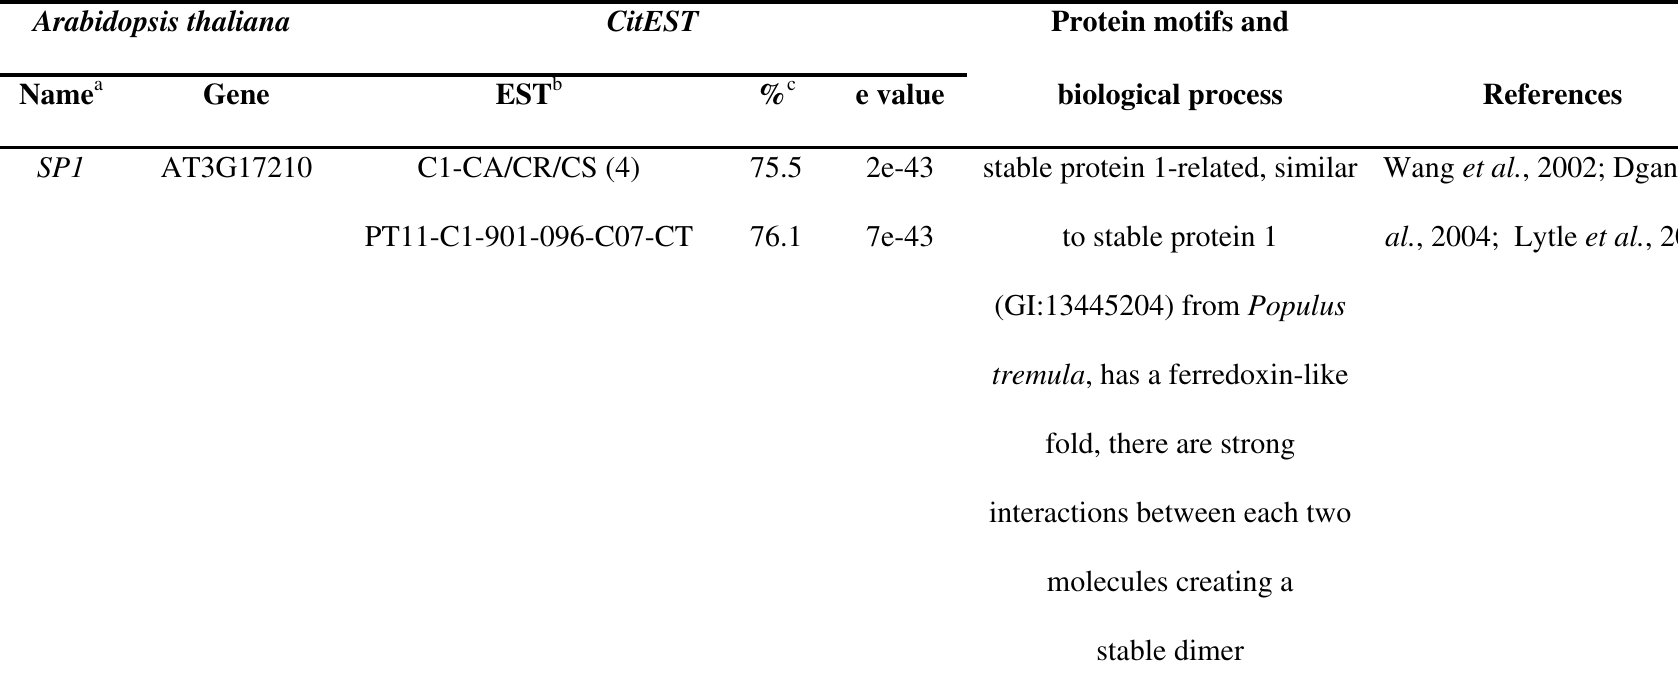
Table S6 –Citrus ESTs with homology to the SP1-related coding genes from Arabidopsis thaliana